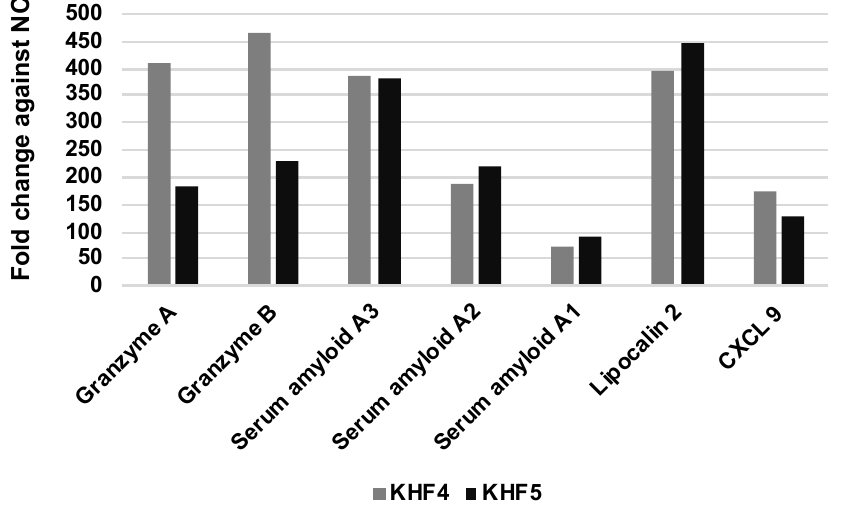
Figure 8. Liver gene expression profiling using microarrays. Transcriptional changes were compared in KHF4, KHF5, and mock-infected mice. The top ten genes showing the maximum fold-change difference in KHF4/KHF5-infected mice relative to the controls were selected and compared.